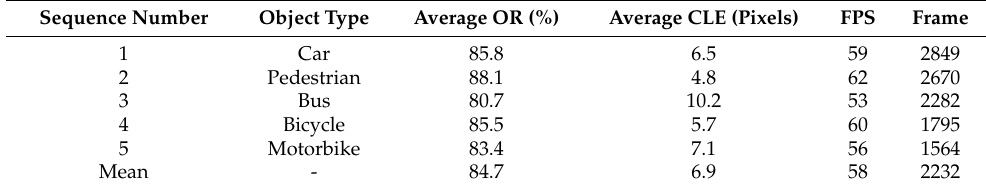
Figure 9. Representative images of the tracking results of the proposed algorithm for different actual driving video sequences. Table 6. The tracking results for various types of objects in the actual driving video sequences.